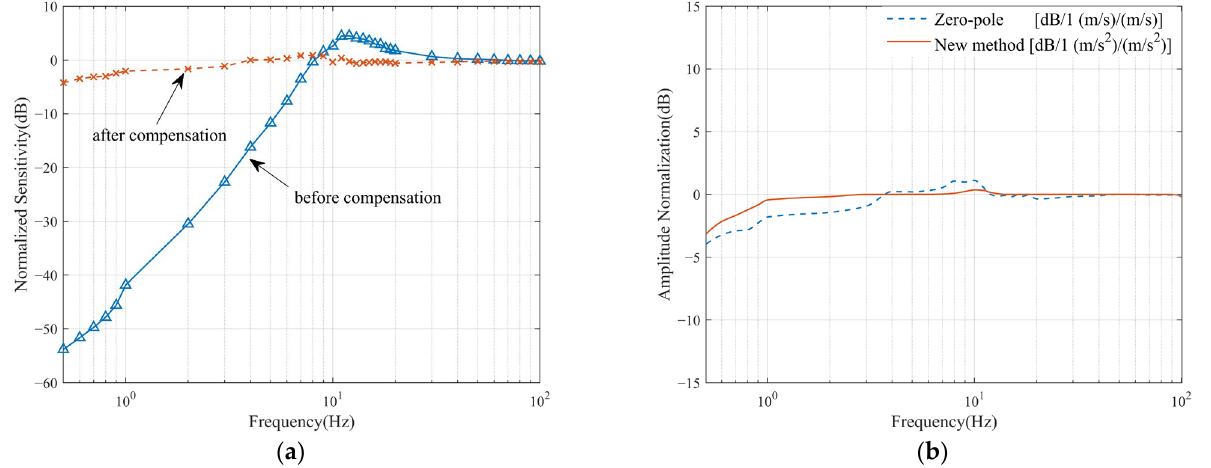
Figure 7. ( a ) Effect diagram of zero-pole compensation; ( b ) normalized amplitude-frequency curves of the two methods.